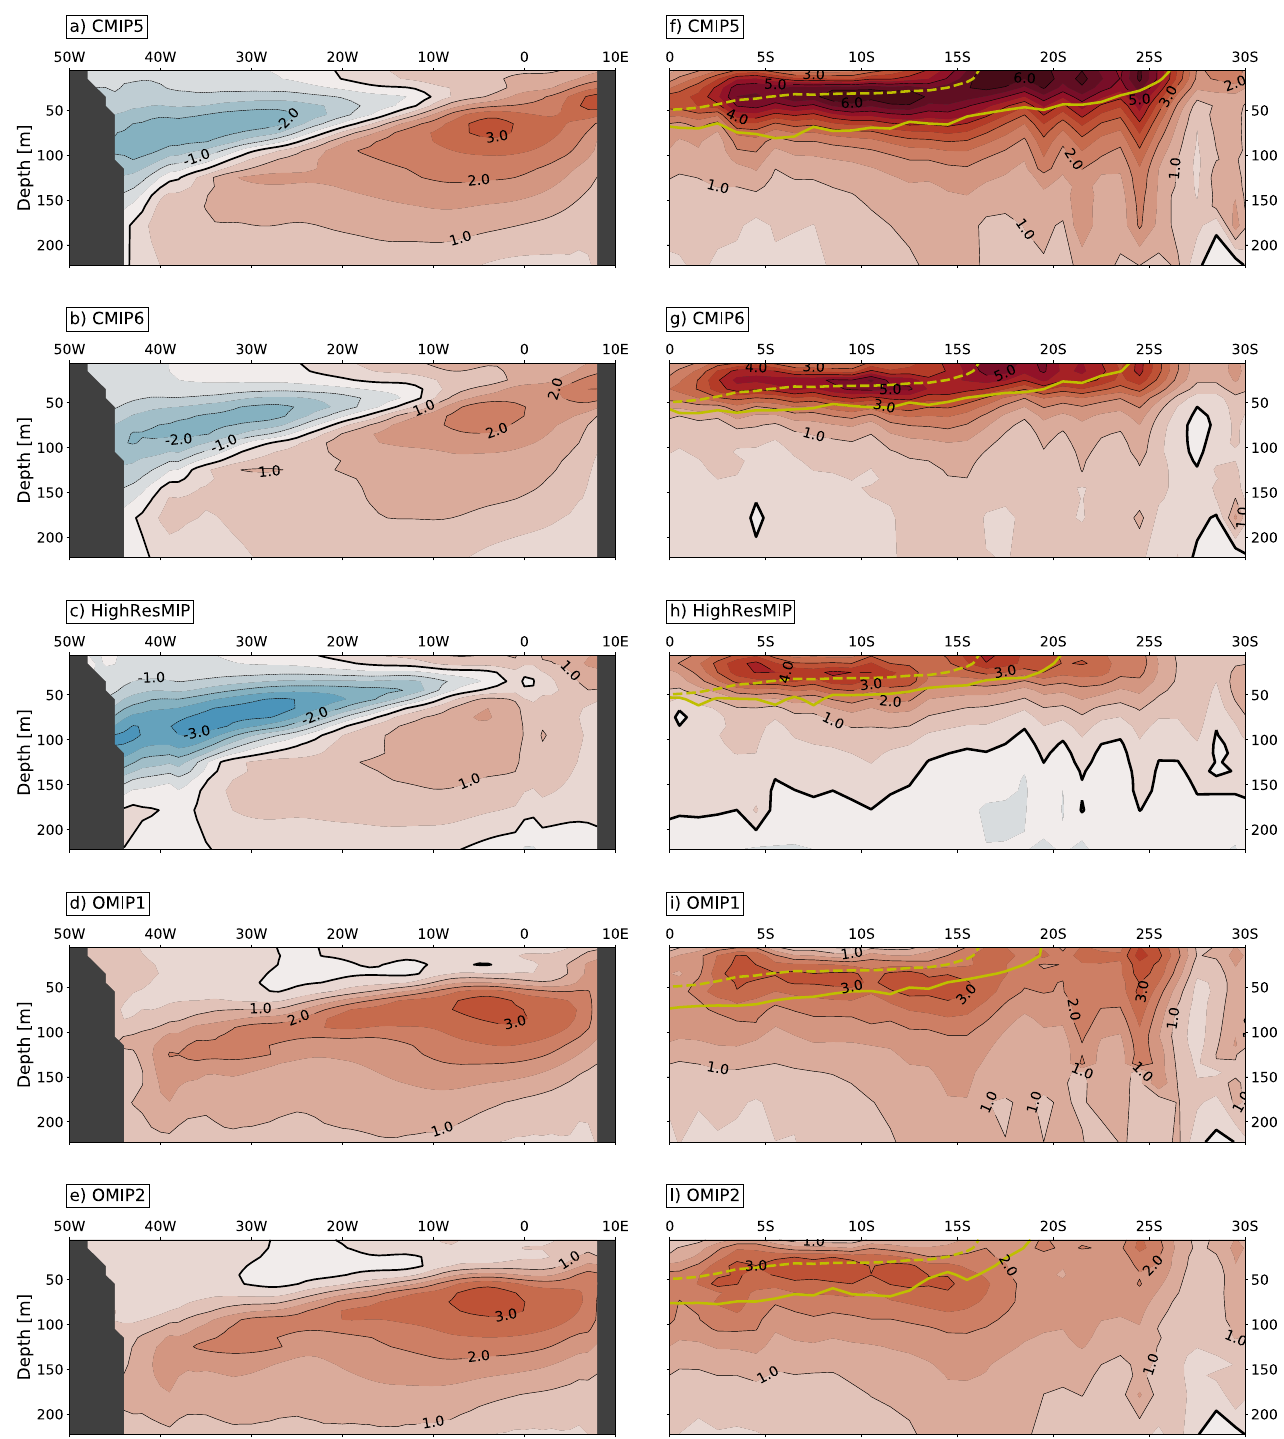
Fig. 6 Equatorial and SETA subsurface temperature biases. a – e Time-mean subsurface equatorial temperature biases (zonally averaged between 2 ∘ S and 2 ∘ N) in CMIP5, CMIP6, HighResMIP, OMIP1 and OMIP2 MMMs relative to WOA18. f – l Time-mean subsurface temperature biases along the African coast, zonally averaged over a 2 ∘ wide band along the coast, for all MMMs relative to WOA18. Contour interval is 1 ∘ C. The solid and dashed yellow contour indicate the depth of the 20 ∘ C isotherm in the MMMs and WOA18, initialized seasonal hindcast simulations have shown the hor- bias in the western tropical Atlantic in all coupled models (Fig. izontal advection of warm anomalies propagating along the 6a – c), which is absent in both OMIP MMMs. However, HighResMIP, equatorial thermocline within the equatorial undercurrent and OMIP1 and OMIP2 all suffer from an eastern equatorial subsurface later along the African coast, eventually upwelling in the southern temperature bias of similar intensity to the subsurface bias found Benguela region 21,27 . Our MMM analysis seems to support this along the African coast (Fig. 6c – e and h – l). Indeed, full- fi eld